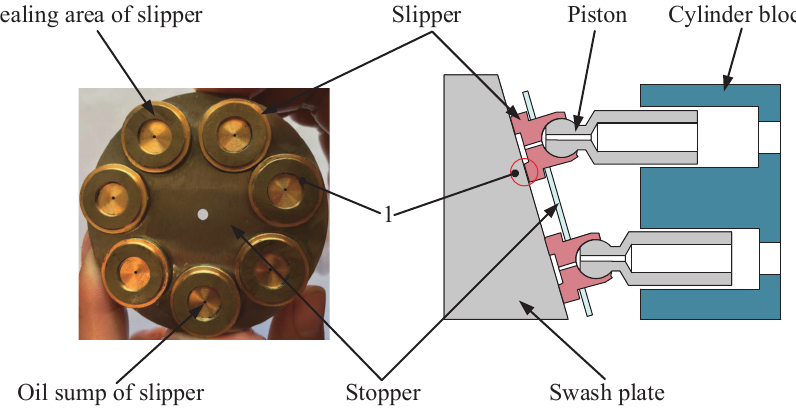
Figure 1. Structure of slipper pair. 1 is the inner edge of the